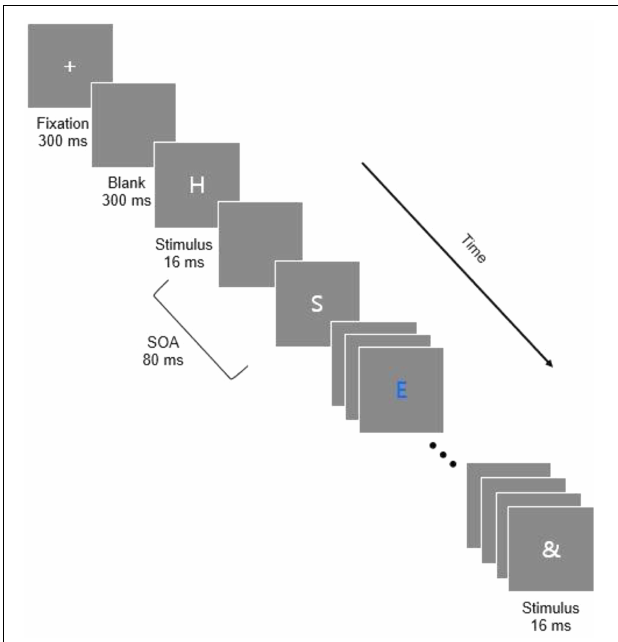
FIGURE 1 | The sequence of stimulus events within a stream for the RSVP task. Each RSVP stream contained 16 letters. The identities of the target and distractors varied from trial to trial. In these examples, the target is the letter E in